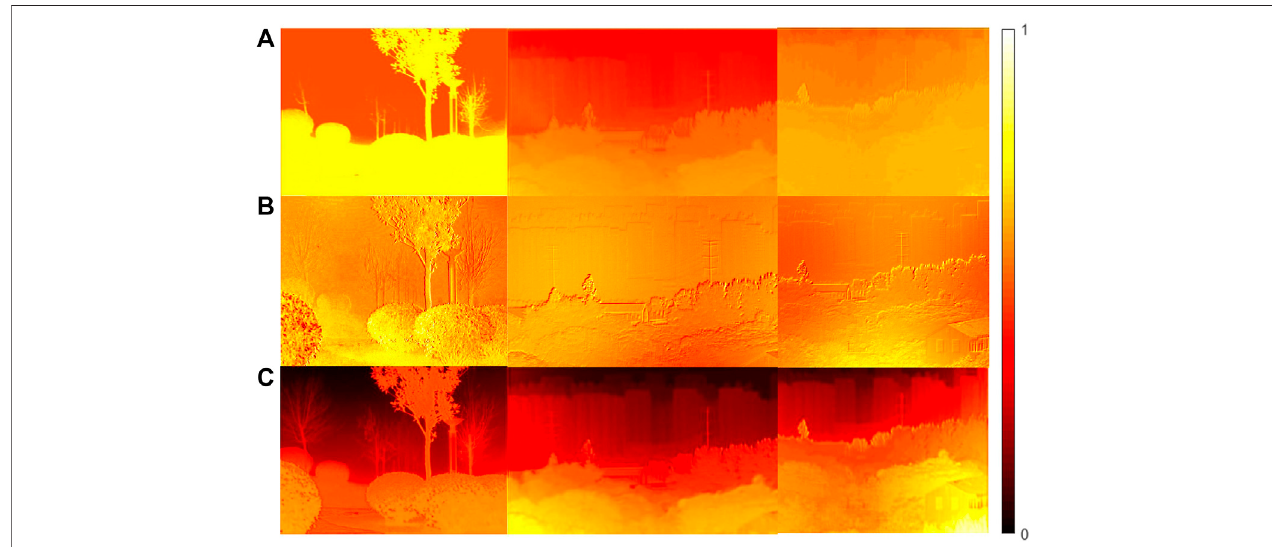
FIGURE 2 | Comparison of the transmission map. (A) Transmission map estimated by PSDNet-T 1 . (B) Transmission map calculated by scene polarization state. (C) Transmission map for the fi nal use dehazing after fusion by PSDNet-T 2 .